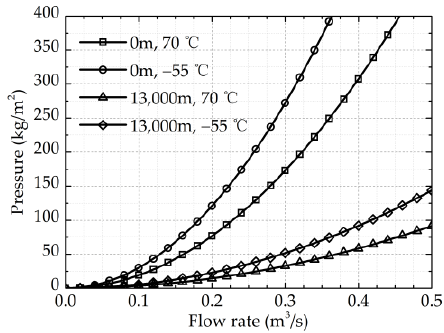
Figure 10. Ventilation resistance characteristics of the BSG.